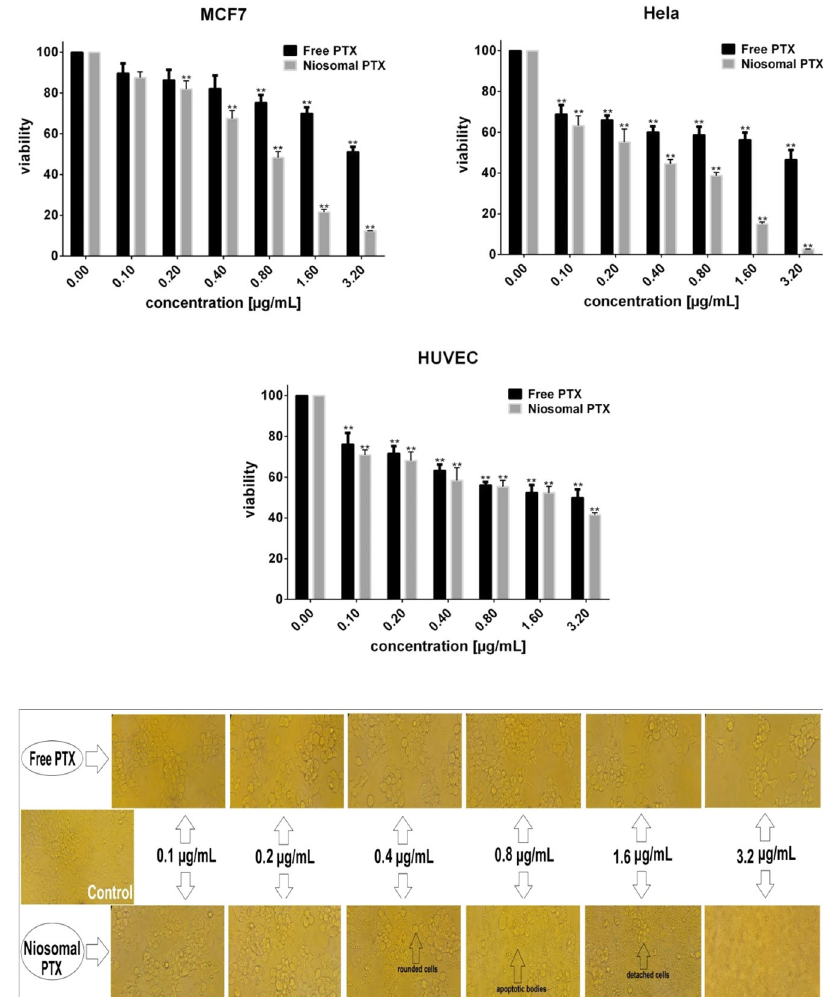
Fig. 6 Cytotoxicity evaluation of free PTX and niosomal PTX on MCF7, Hela, and HUVEC cells after 48 h exposure. (** P < 0.05 compared with untreated cells)